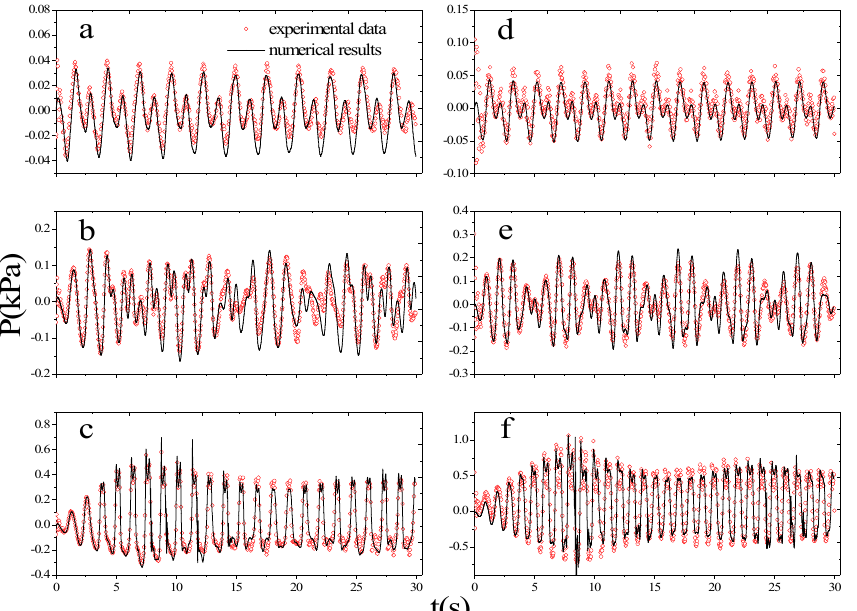
Figure 6. The model validation under different filling levels, external frequencies and the same amplitude of A = 7 mm, ( a ) h = 90 mm, ω = 0.5 ω 1 , ( b ) h = 90 mm, ω = 0.8 ω 1 , ( c ) h = 90 mm, ω = ω 1 , ( d ) h = 200 mm, ω = 0.5 ω 1 , ( e ) h = 200 mm, ω = 0.8 ω 1 , ( f ) h = 200 mm, ω = ω 1 .